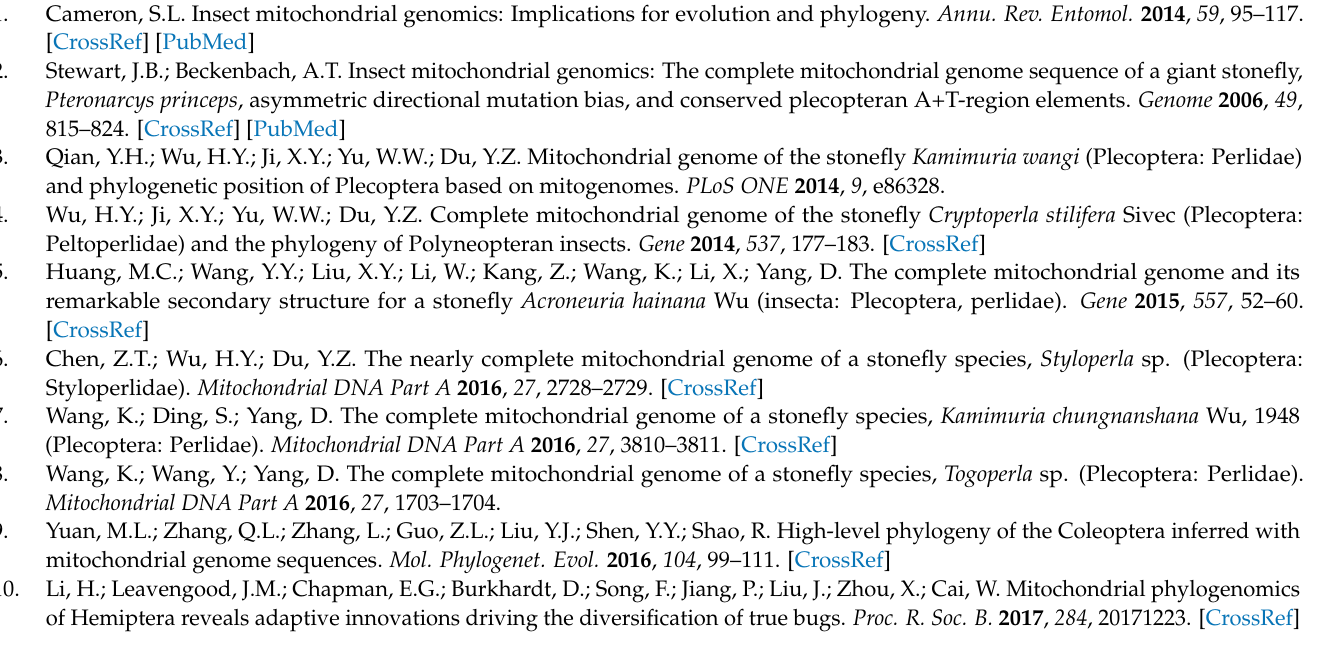
Figure S2: Mitochondrial maps of C. xucheni . Genes outside the map are transcribed clockwise, whereas genes inside the map are transcribed counterclockwise. The interior circles show GC content and the GC skew, and these are plotted as the deviation from the average value of the entire sequence; Figure S3: Predicted secondary structures of tRNAs in claassenia sp.2. The tRNAs are labelled with abbreviations of their corresponding amino acids; Figure S4: Predicted secondary structures of tRNAs in C. xucheni . The tRNAs are labelled with abbreviations of their corresponding amino